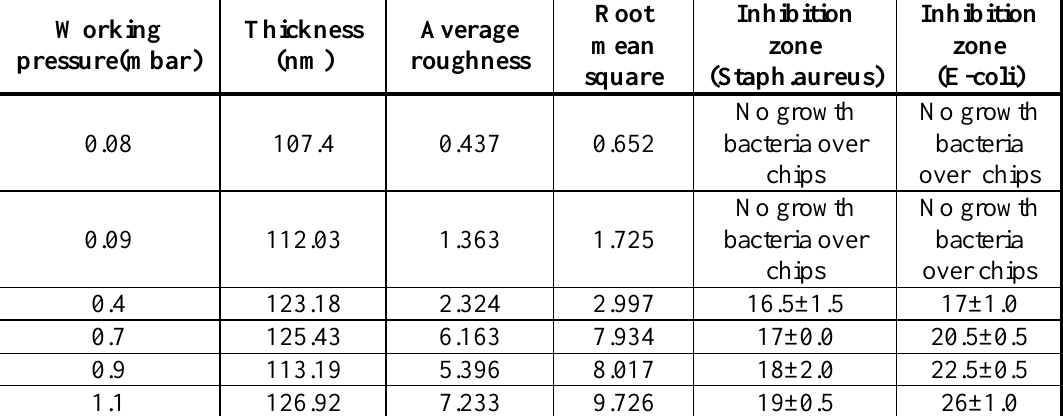
Table 2: The inhibition zone effect for Ag-nanoparticle deposited at different working pressure.